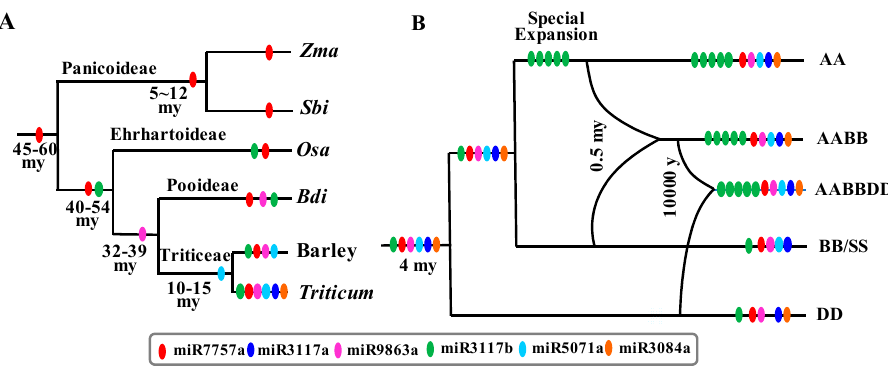
Figure 8. The evolutionary path of the disease resistance-associated miRNAs in ( A ) grasses and ( B ) Triticum species.